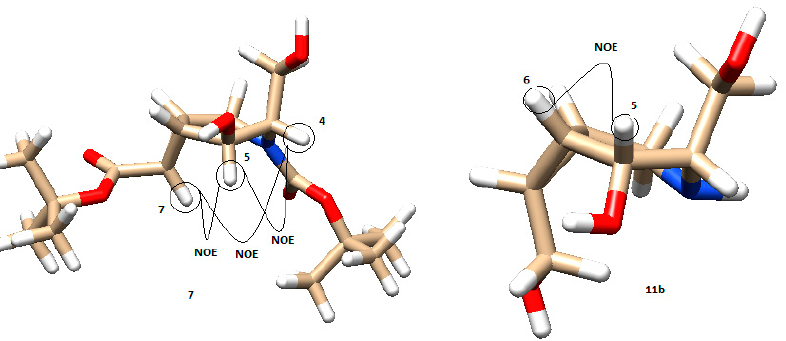
Figure 6. Model of compounds 7 and 11b , respectively, with their main NOE interactions (brown: carbon; white: hydrogen; red: oxygen; blue: nitrogen). carbon; white: hydrogen; red: oxygen; blue: